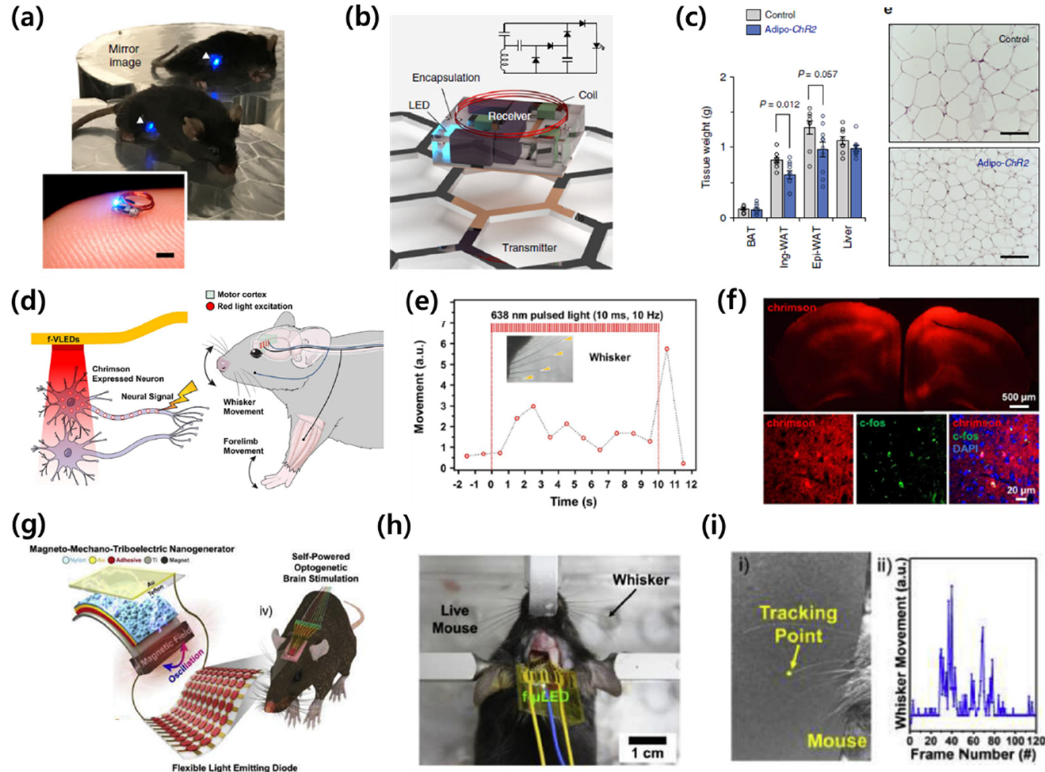
Figure 8. ( a ) Photograph of a freely moving mouse with an implanted wireless optogenetic device. The inset shows a wireless implantable optogenetic device on a human fingertip. Scale bar: 1 mm. ( b ) Illustration of the wireless implantable optogenetic device with circuit diagram, which was composed of µ LED and power receiver coil. ( c ) Tissue weight comparison of Adipo-ChR2 mice and littermate controls. Right images show hematoxylin and eosin (H&E) staining of the inguinal white adipose tissue (WAT) after light stimulations (Control, n = 8; Adipo-ChR2, n = 10). Reproduced with permission [54]. Copyright 2020, Springer Nature. ( d ) Schematic illustration of optogenetic brain stimulation for modulating mouse behaviors, which was fulfilled by flexible red µ LEDs. ( e ) Tracking graph of mouse whisker movement for 10 ms stimulation by red light. ( f ) Confocal images of the sliced mouse brain after optogenetic stimulation. Top image shows chrimson-expressed frontal motor cortex. Bottom images indicate cortical neurons, which were co-expressed by chrimson (red) and c-fos (green). Reproduced with permission [40]. Copyright 2018, Elsevier. ( g ) Schematic illustration of self-powered optogenetic stimulation by flexible µ LEDs and a magneto-mechano-triboelectric nanogenerator. ( h ) Experimental image for optogenetic brain stimulation, showing implantation of flexible µ LEDs under the anesthetized mouse skull. ( i ) Tracking of mouse whisker movement during self-powered optogenetic stimulation. Reproduced with permission [17]. Copyright 2020,